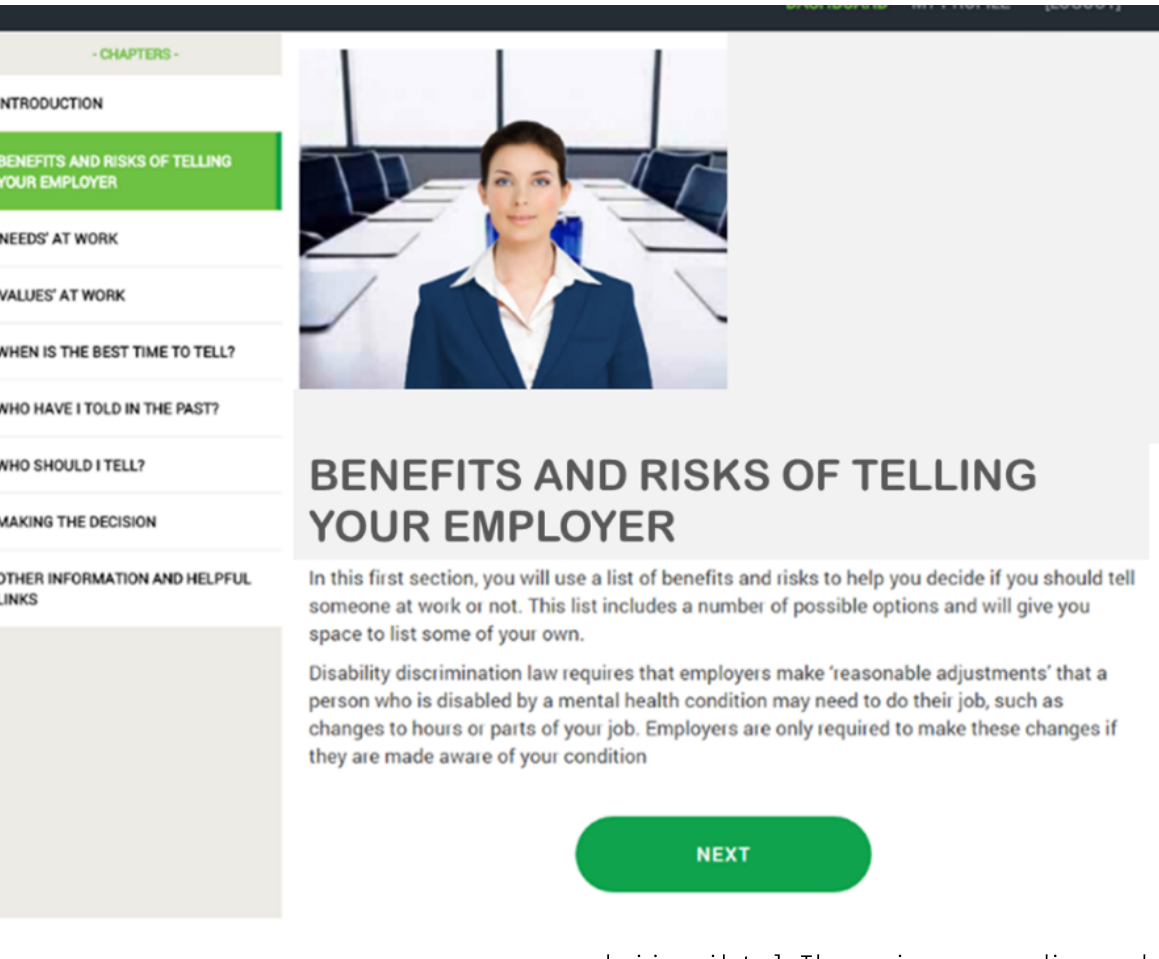
Figure 1. Example of avatar used in workshops as a